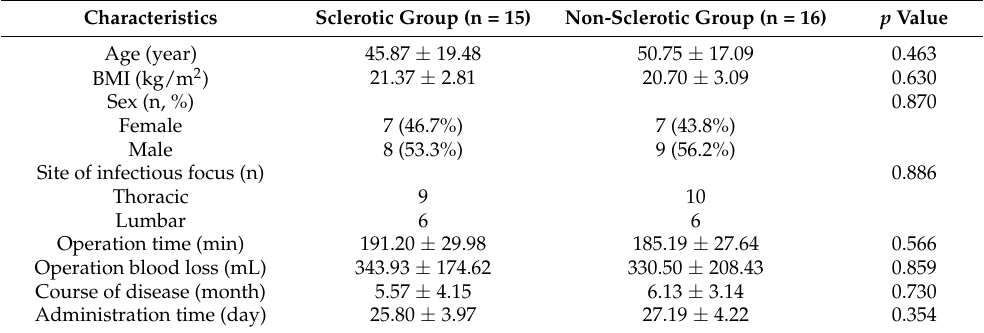
Table 1. Perioperative characteristics of 31 thoracic and lumbar tuberculosis